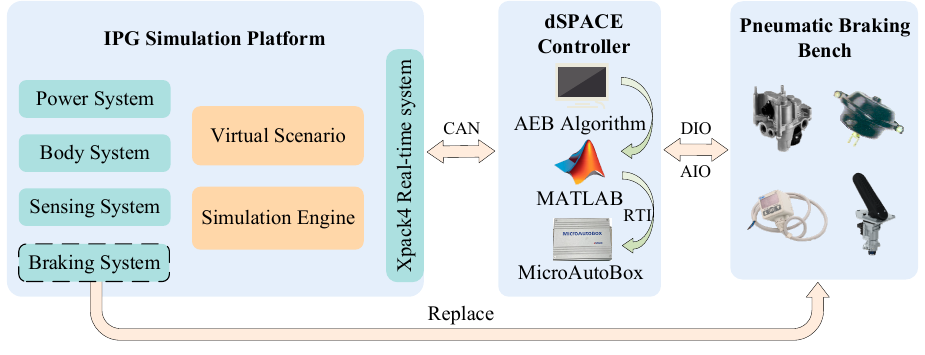
Figure 7. HIL testing method.